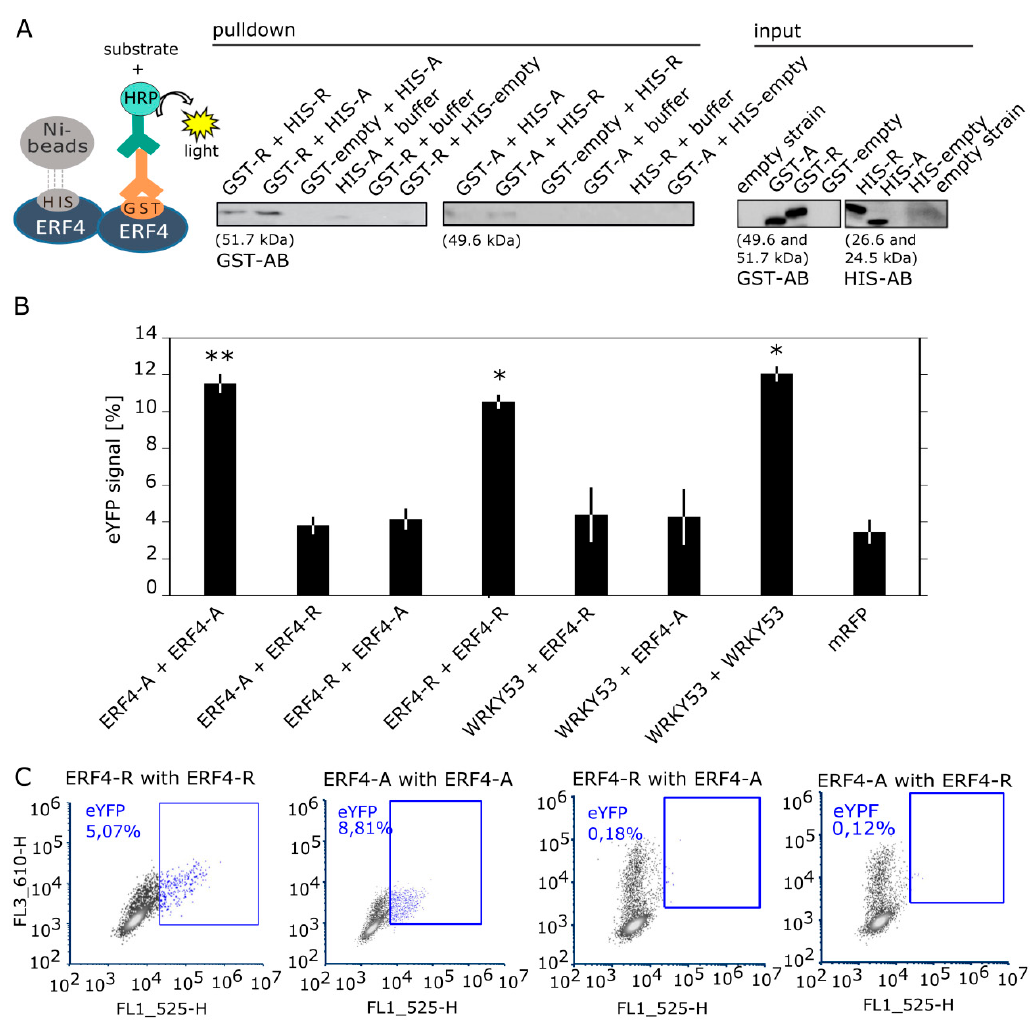
Figure 6. Protein–protein interaction of ERF4-A and ERF4-R . ( A ) Pull-down assay was performed using total protein extracts from E. coli BL21 Rosetta cells. GST-tagged ERF4-R (51.7 kDa) and ERF4-A (49.6 kDa) was pulled down with HIS-tagged ERF4-R (26.6 kDa) and ERF4-A (24.5 kDa) proteins and immunodetected with anti-GST antibodies. The input protein (25 µg) was visualized with anti-GST and anti-HIS antibodies. The experiment shown was performed three times with similar results. ( B ) BiFC flow cytometry experiments were performed in Arabidopsis protoplasts co-expressing ERF4-R and ERF4-A fused with YFP-N and YFP-C, respectively. YFP-N fusion with WRKY53 and YFP-C fusions with both ERF4 isoforms were used as negative controls and YFP-N and YFP-C fusions with WRKY53 as positive control. RFP is expressed as transfection control. Bars represent percentage of cells with eYFP signal (mean values (±SE), n = 7 for combinations with ERF4 isoforms, n = 3 for combinations with WRKY53). Data was subjected to quantile normalization and determination of statistical differences was carried out using Wilcoxon rank sum test (* p ≤ 0.05, ** p ≤ 0.005). ( C ) Representative graphs of the flow cytometry results for ERF4 homodimers and heterodimers. Blue dots represent eYFP signals of interaction. Blue squares mark the cells showing eYFP signal.